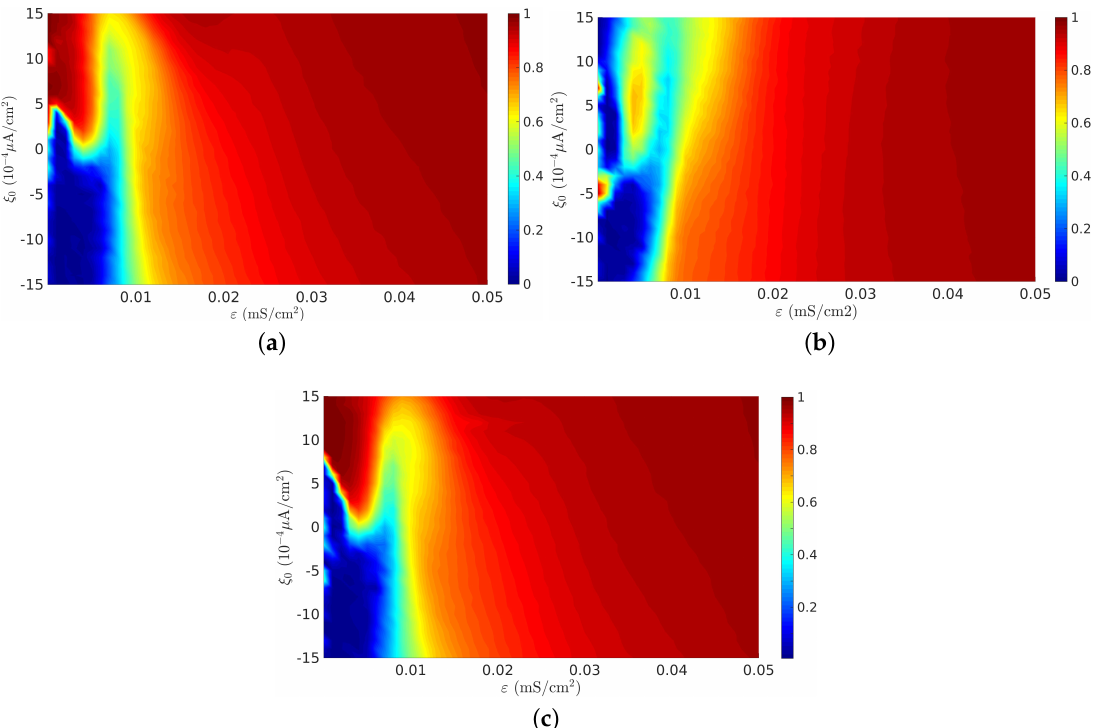
Figure 8. (cid:104) R (cid:105) as functions of ε and the amplitude of the current ξ 0 for different delay times t delay : ( a ) t delay = 0; ( b ) t delay = 500 ms; and ( c ) t delay = 1000